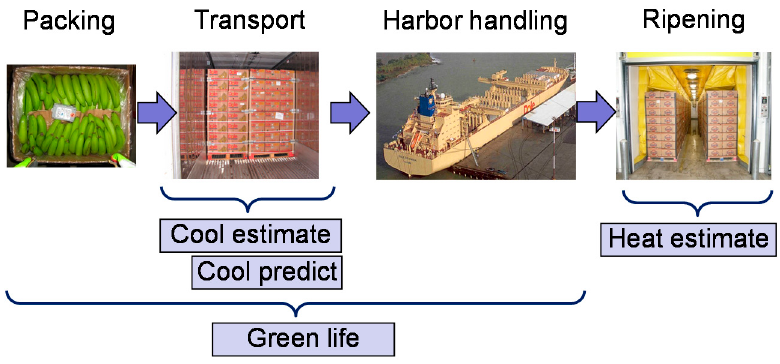
Figure 2. Banana chain and valid timeslots for models.